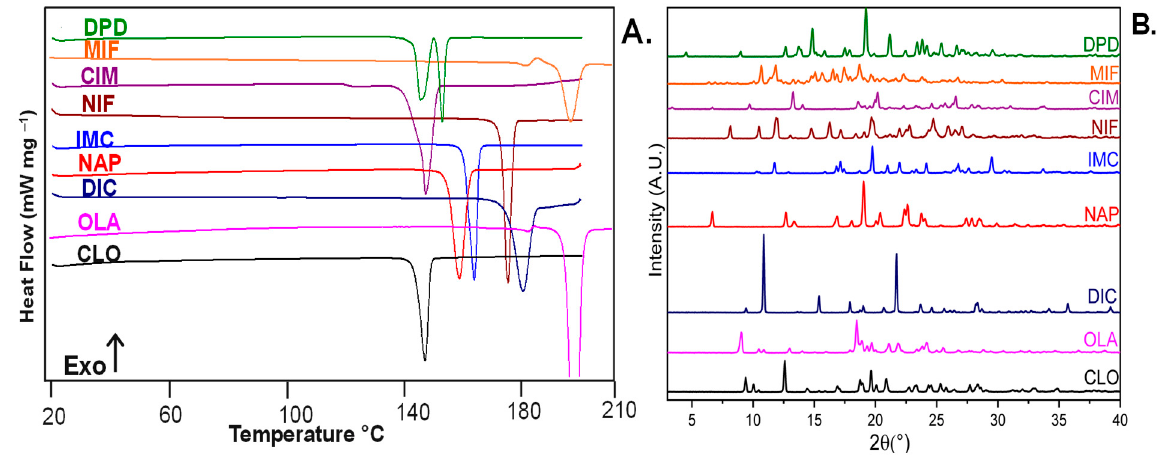
Figure 2. DSC heating curves ( A ) and pXRD profiles ( B ) of selected drug compounds.